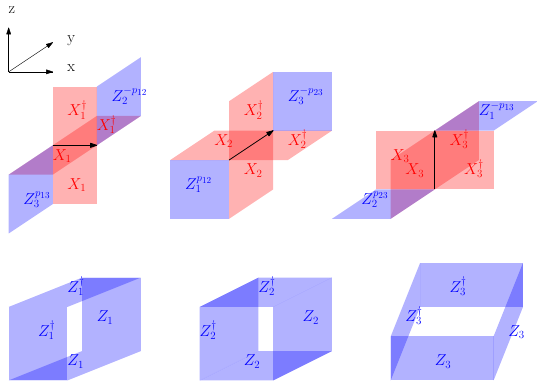
Figure 3: Hamiltonian model for the twisted foliated (cid:90) gauge theory. We label the N top row of excitations as e Y Z , e XZ , e XY , and the bottom row as f 1 , f 2 , f 3 (from left to right). Each face has two (cid:90) degrees of freedom: a x k − x l planar face has an N x k -type and x l -type (cid:90) degree of N